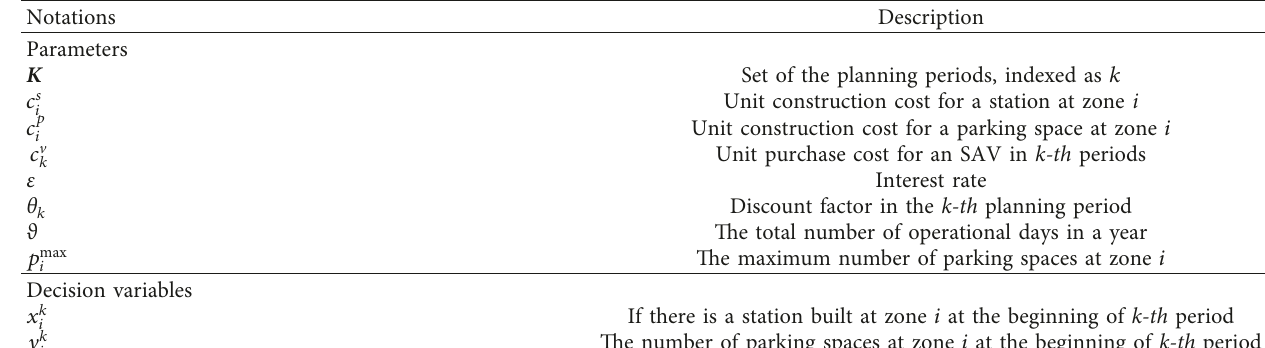
Table 2: Variables and parameters used in the long-term planning of the SAV